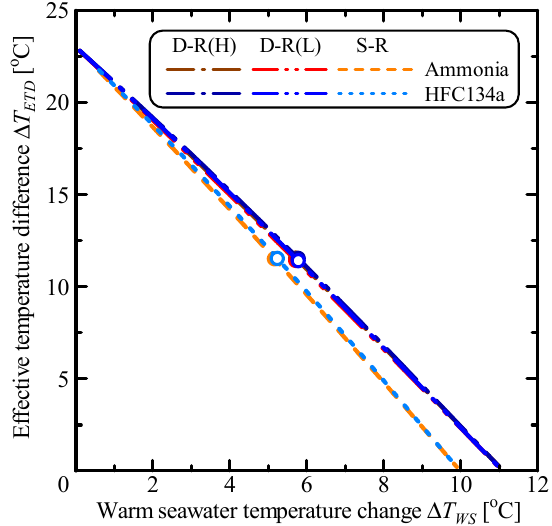
Figure 14. Relationship between the condensation pressure and the thermal efficiency of the cycle.